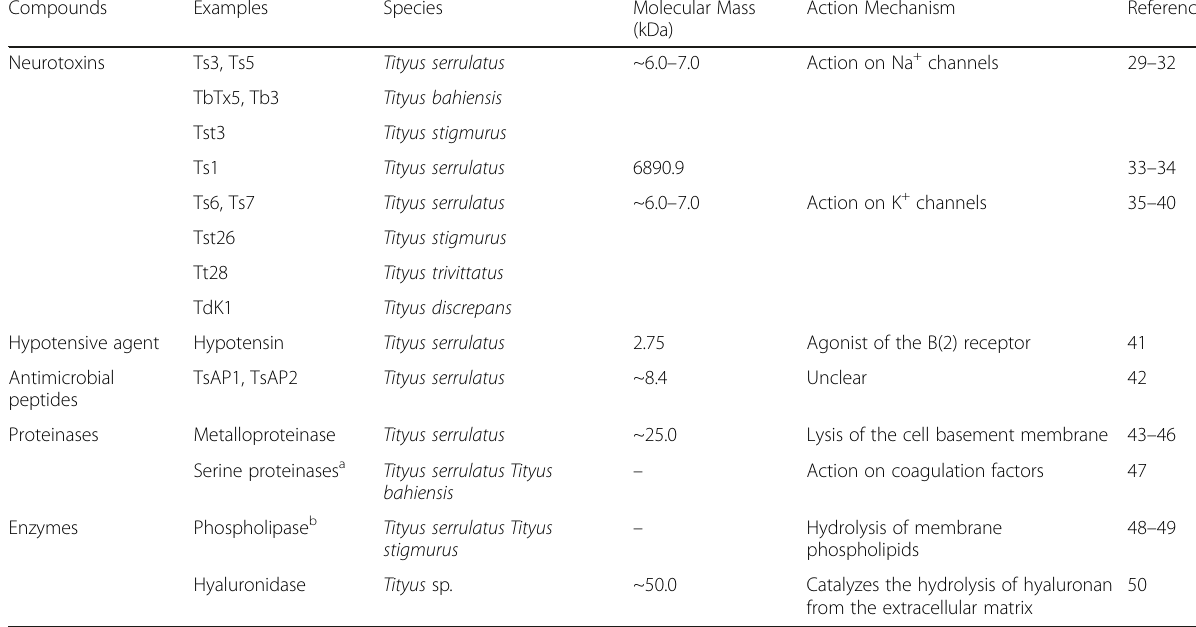
Table 1 Examples of compounds from Tityus scorpion venoms